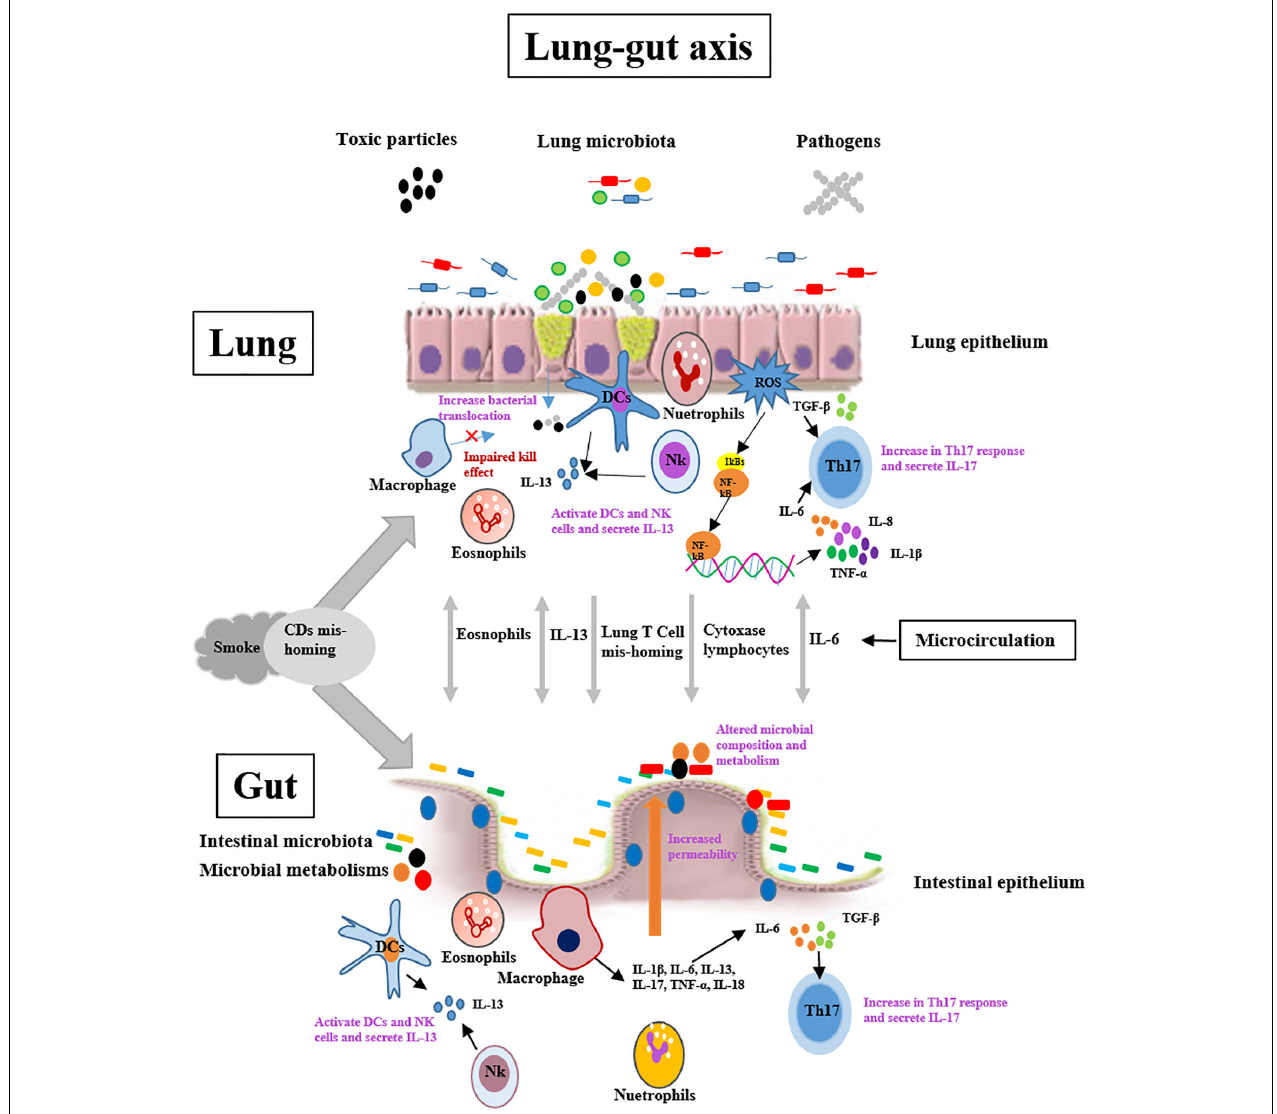
FIGURE 1 | Potential mechanisms of lung-gut cross talk include lung-originating T-cell and eosinophils mis-homing and increases the expression of cytochrome oxidase in lymphocytes. Cigarette smoke exposure may exert important roles in organ cross-talk by affecting these processes, and/or by causing DCs mis-homing in the lungs and gut. Systemic IL-6 combined with local TGF- β may drive cross-organ Th17-polarized inflammation. Systemic IL-13 may stimulate NK cell and macrophage responses in organ cross-talk. DCs = dendritic cells; IL-6 = Interleukin-6; TGF- β = Transforming growth factor- β ; NK cell = Natural killer cell.